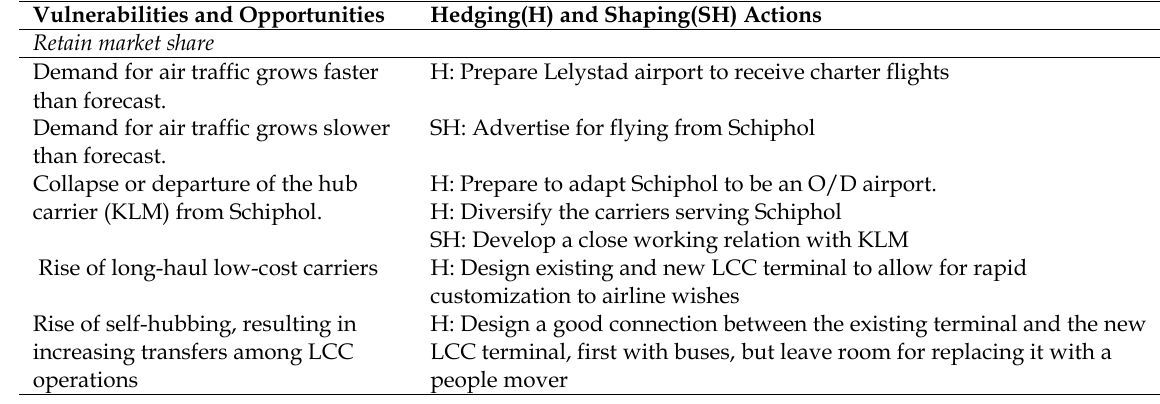
Table 3. Uncertain Vulnerabilities and Opportunities, and Responses to Them Vulnerabilities and Opportunities Hedging(H) and Shaping(SH)